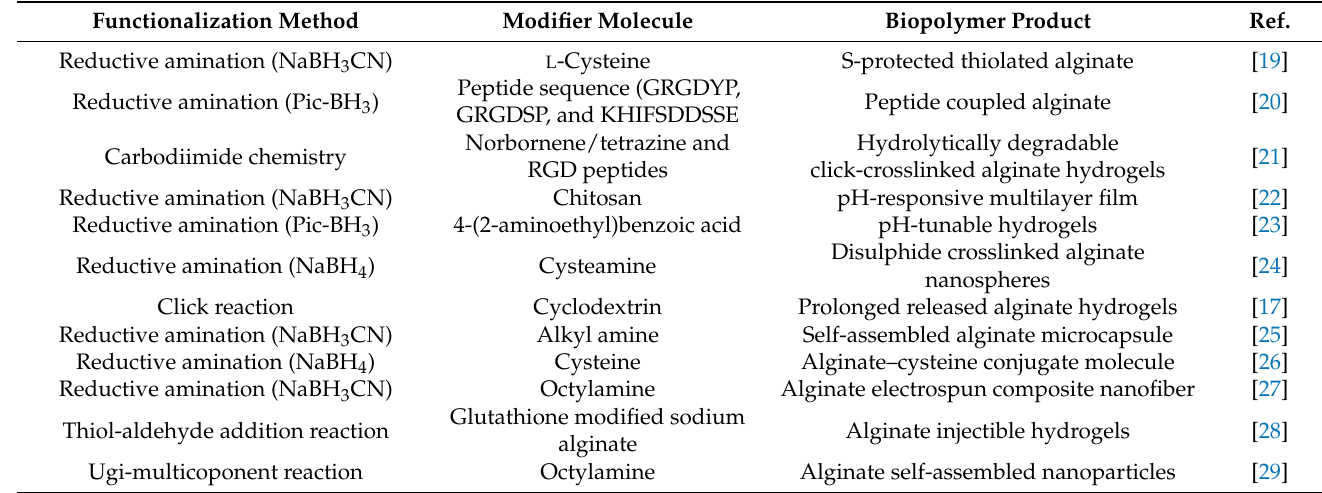
Table 1. An overview on the research into the functionalization of alginate dialdehyde. Functionalization